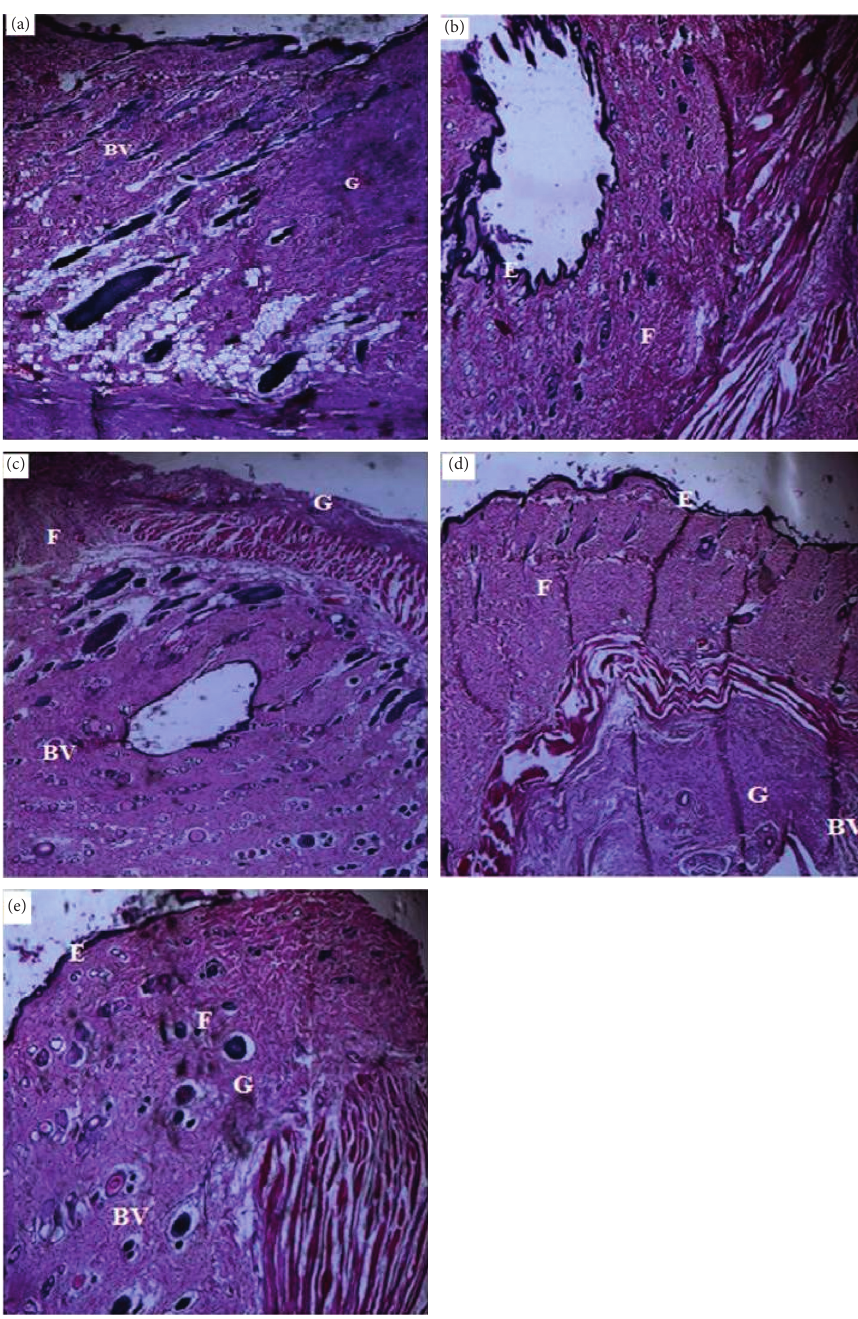
Figure 3: Sample photomicrographs showing effects of: (a) simple ointment BP, (b) 5% CFHE ointment, (c) 10% CFHE ointment, (d) 15% CFHE ointment, and (e) silverzine on excised scar tissues from Albino rat. BV � blood vessels, E � epidermal cells, G � granulation, F � fibroblast proliferation. Hematoxylin and eosin staining ( ×